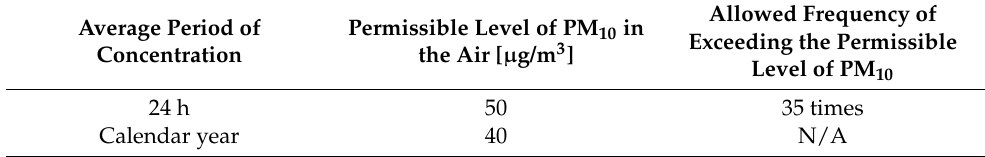
Table 1. Acceptable daily and annual maximum levels of PM 10 concentration in the air.